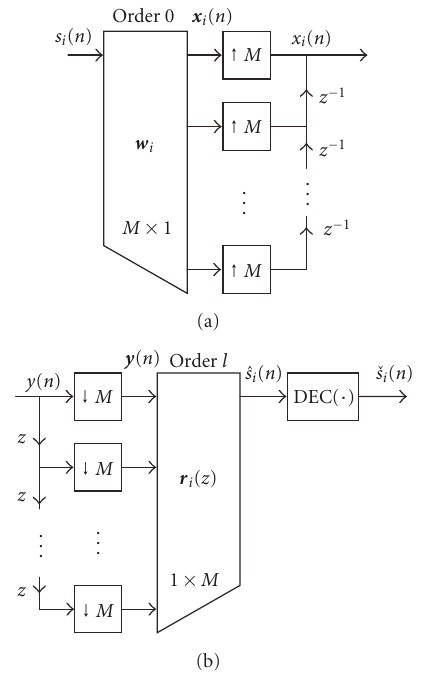
Figure 1: (a) DS-CDMA transmitter number i . (b) DS-CDMA receiver part designed for decoding user number i